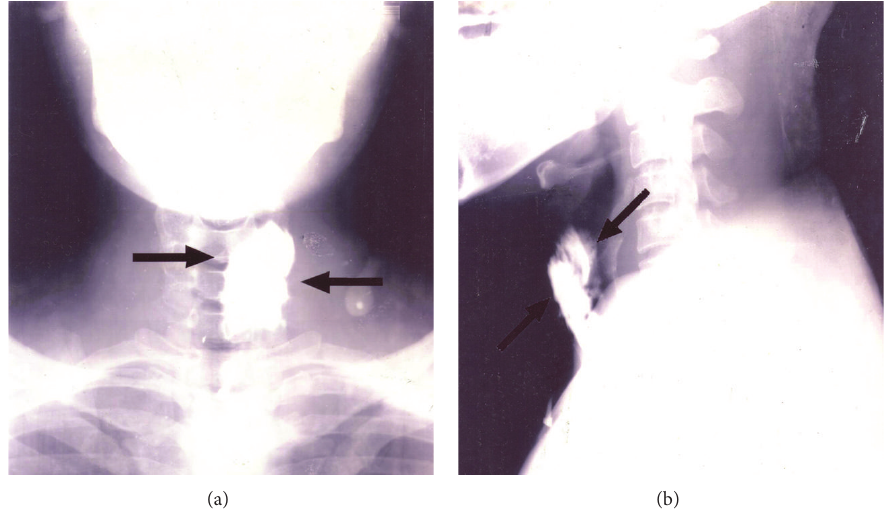
Figure 1: Contrast X-ray showing 4th branchial